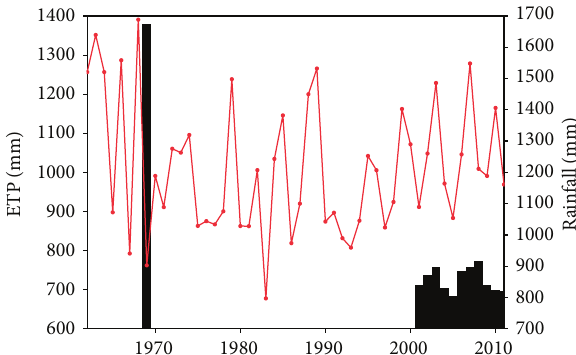
Figure 7: Annual evolution of PE (black bars) and rainfall (red line) during